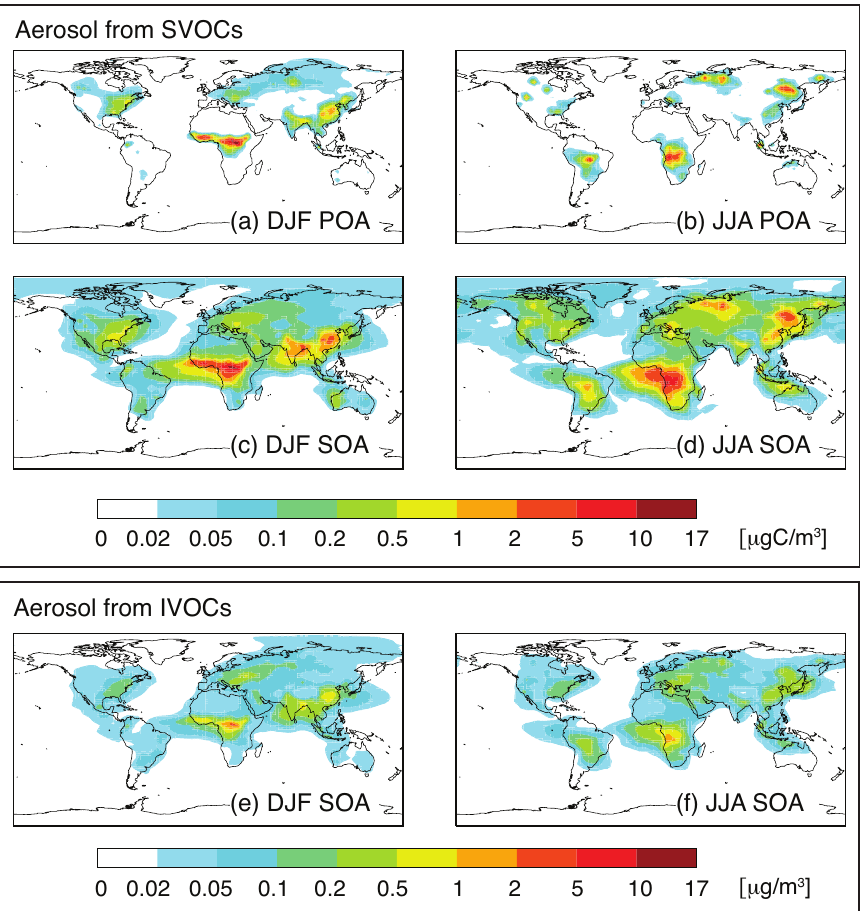
Fig. 2. Predicted concentration of aerosol from SVOCs and IVOCs. Aerosol from SVOCs includes POA, ( a and b ), and SOA, ( c and d ), and is expressed in µg C/m 3 . Aerosol from IVOCs is shown in panels ( e and f ) and is expressed in µg/m 3 . Concentrations are shown at the surface for December-January-February (DJF) and June-July-August (JJA) for year 2000 (GEOS-4, 2 ◦ × 2 . 5 ◦ ). Note that the color scale is not linear.